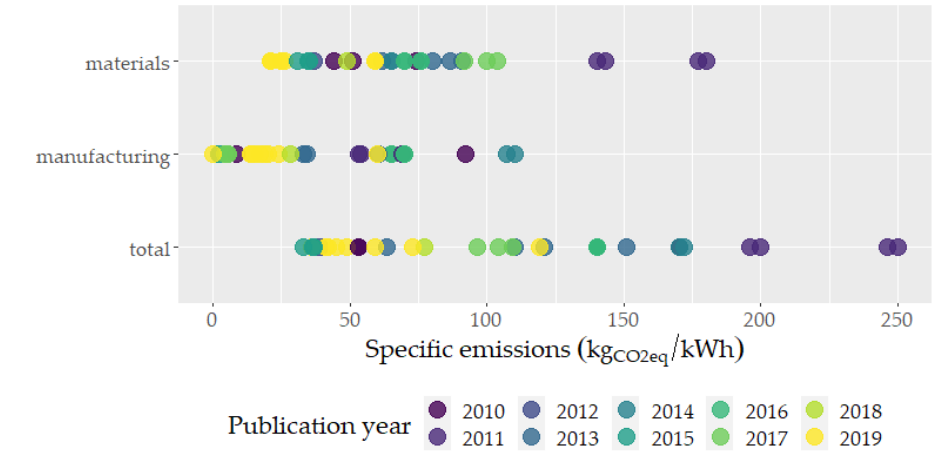
Figure 3. Specific emissions related to Li-ion cells production. The authors’ elaboration on